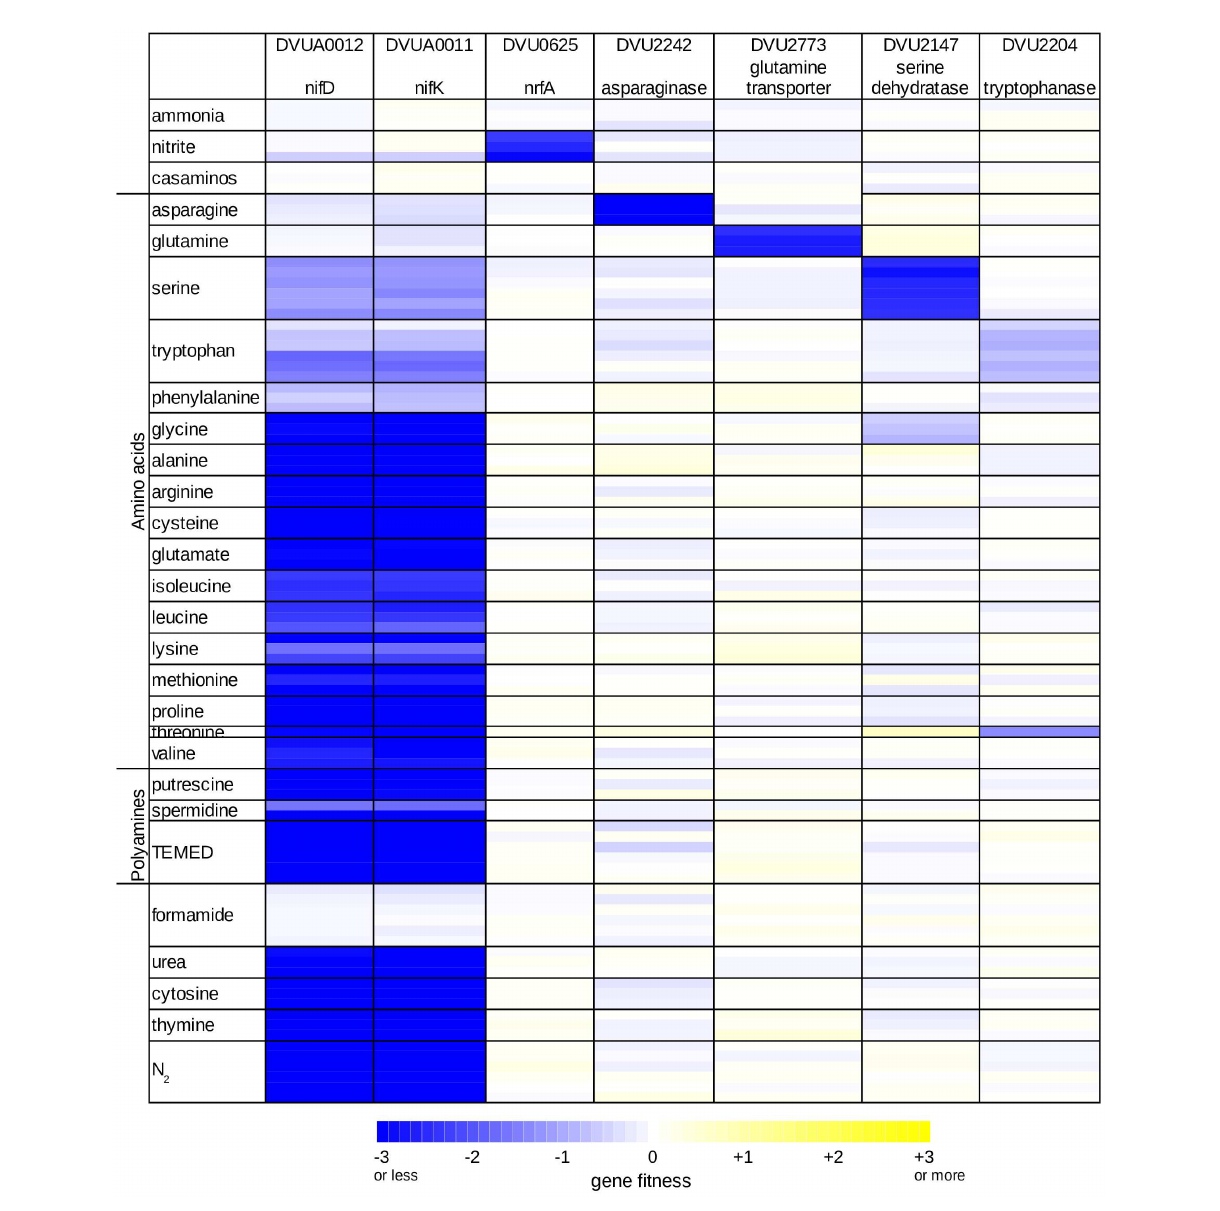
FIGURE 5 Overview of nitrogen utilization in D. vulgaris Hildenborough. Heatmap of gene fitness data for select genes in experiments where the nitrogen source was varied. For each condition, we show the data from each replicate experiment separately. TEMED is tetramethylethylenediamine; casaminos is casamino